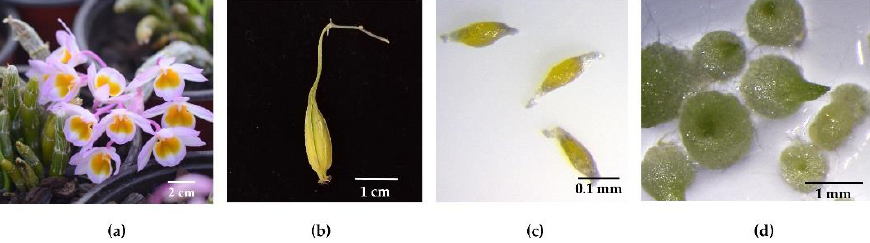
Figure 1. Plant material of D. crepidatum . ( a ) The flowers of D. crepidatum ; ( b ) The capsules of D. crepidatum ; ( c ) Seeds swollen after absorbing water; ( d ) The protocorms of D. crepidatum . Bar: ( a ) 2 cm, ( b ) 1 cm, ( c ) 0.1 mm, ( d ) 1mm.